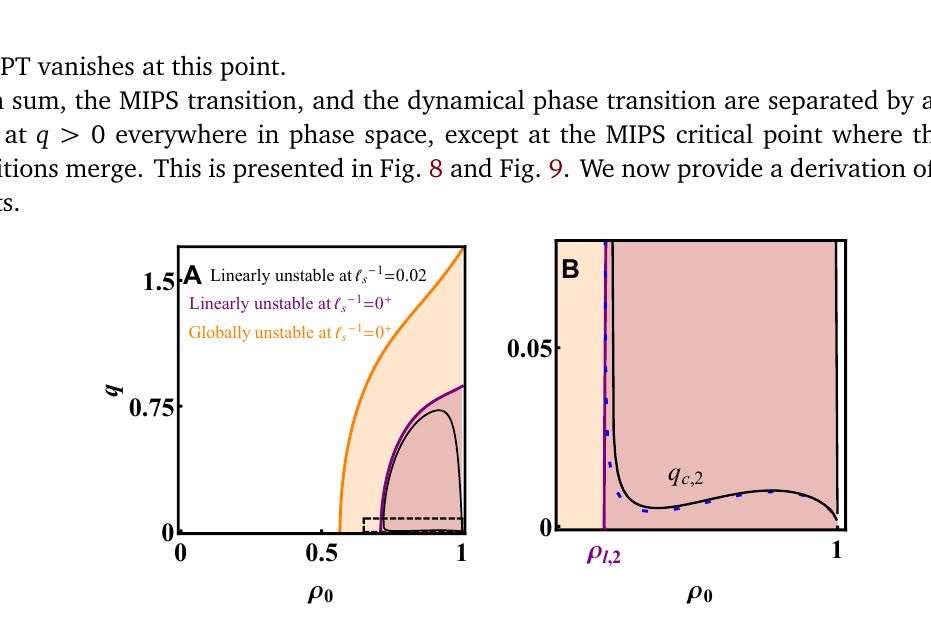
Figure 7: The phase diagrams of the DPT and of MIPS. The MIPS binodal is shown as a black solid line and the corresponding spinodal as a dashed black line. The binodal ) , which is given by Eq. (36), is plotted for dynamical phase transition at q = O ( ℓ − 1 / 2 s in orange. The dashed purple line is the corresponding spinodal, Eq. (37). Their extension in the MIPS phase is denoted by dotted lines.